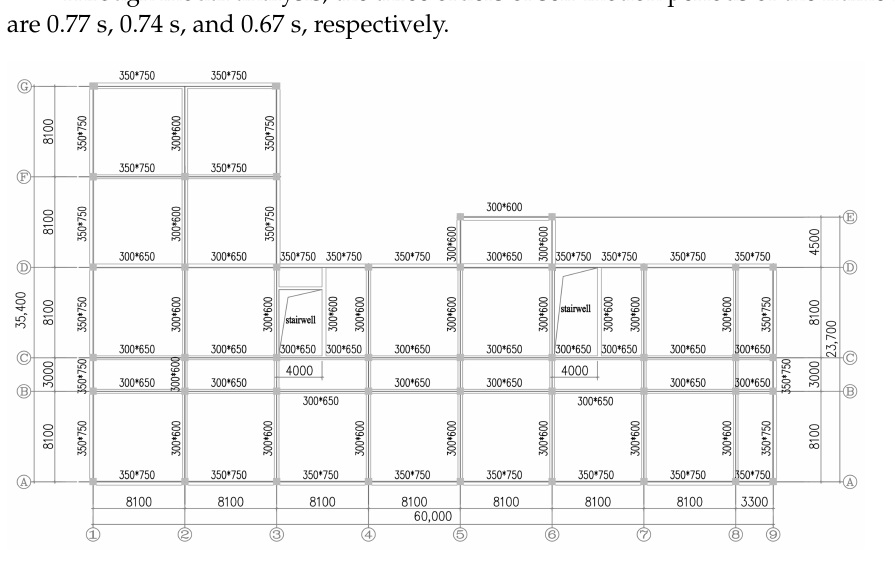
Figure 3. Layout of RC frame structure (unit: mm).